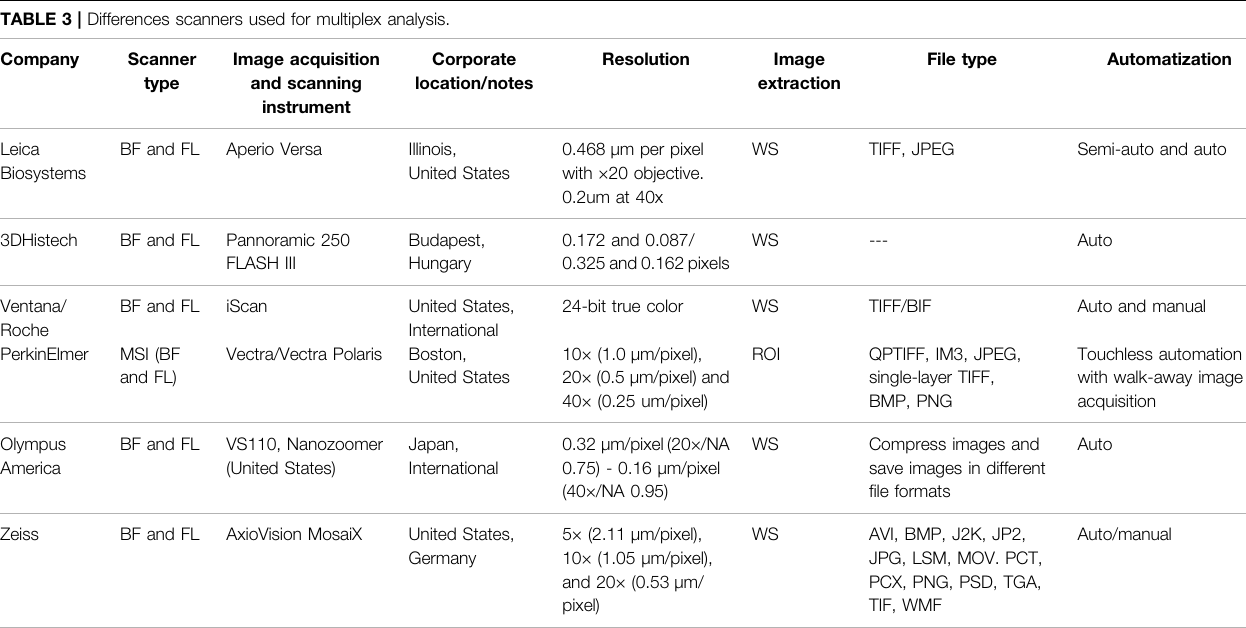
TABLE 3 | Differences scanners used for multiplex analysis.